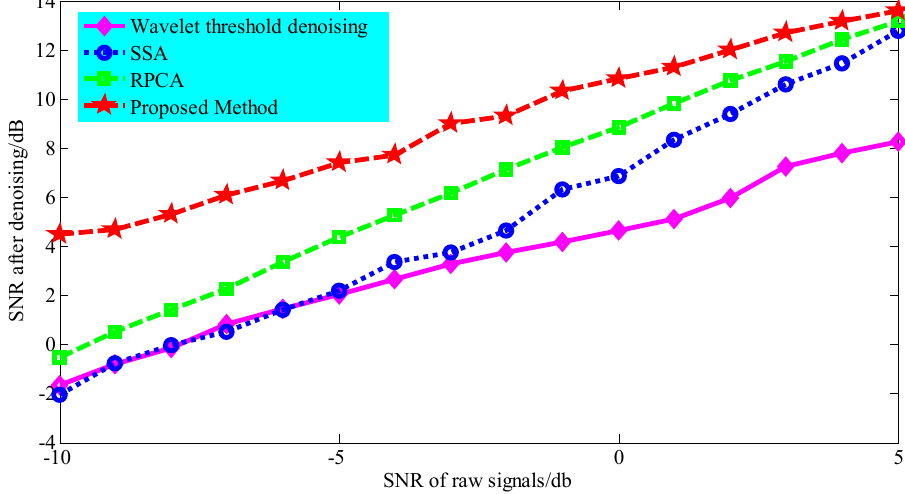
Figure 8. Comparison of the denoising performance of the four methods when white Gaussian noise with di ff erent SNR values was added to the multi-component